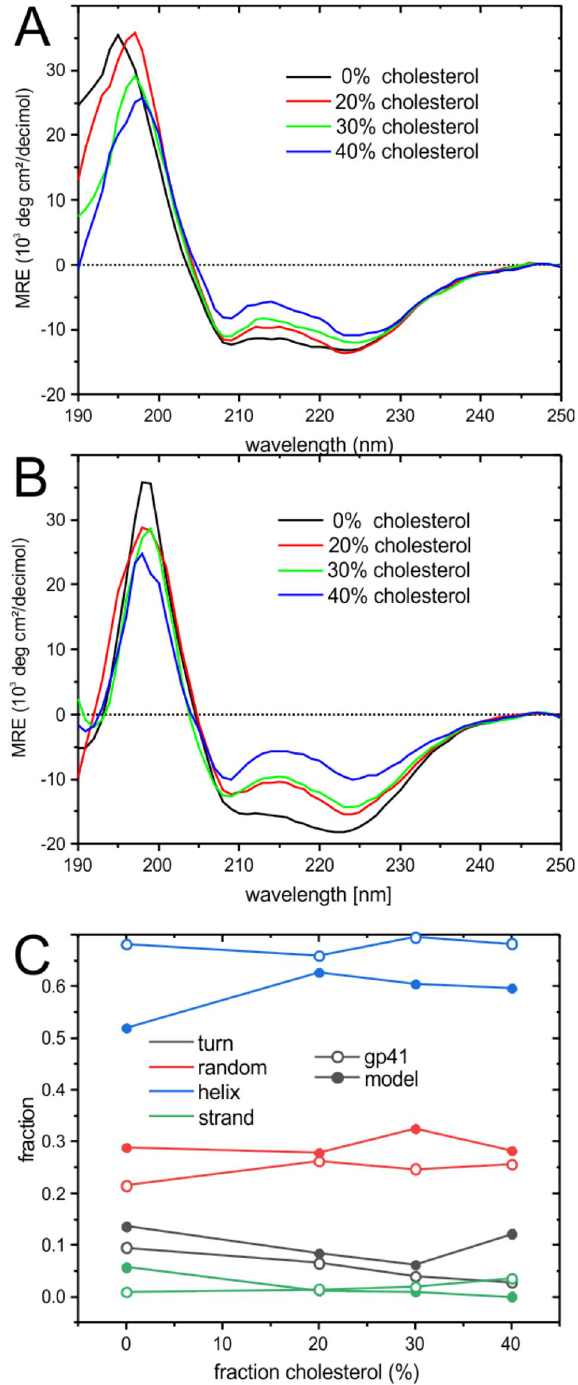
Figure 2. CD spectra of ( A ) CRAC-TM_model and ( B ) CRAC-TM_gp41 after reconstitution into POPC/POPS 3/1 mol/mole SUVs with increasing concentrations of cholesterol at a peptide-to-lipid ratio of 1 mol%. The peptide concentration was 25 µM in 10 mM phosphate buffer, pH 7, at 20 °C. ( C ) Fit results of the CD spectra of CRAC-TM_model (closed symbols) and of CRAC-TM_gp41 (open symbols) using the CONTIN/LL algorithm and the base set SMP56 of CDPRO. Comparison of the experimental spectra and the fits are shown in Figure